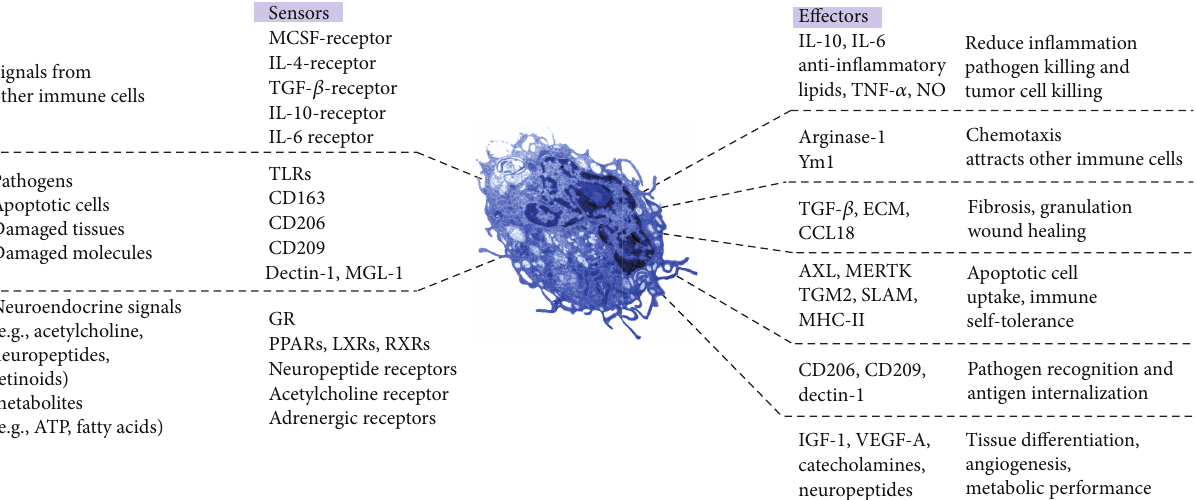
Figure 2: Alternative model depicting sensor and effector functions of the M2 macrophages. The macrophage phenotype is principally determined by eliciting signals, derived from immune cells, pathogens, apoptotic or damaged cells, and a wide range of chemical mediators. They act through receptors and signal pathways which elicit a wide range of effector functions. Abbreviations are defined in the